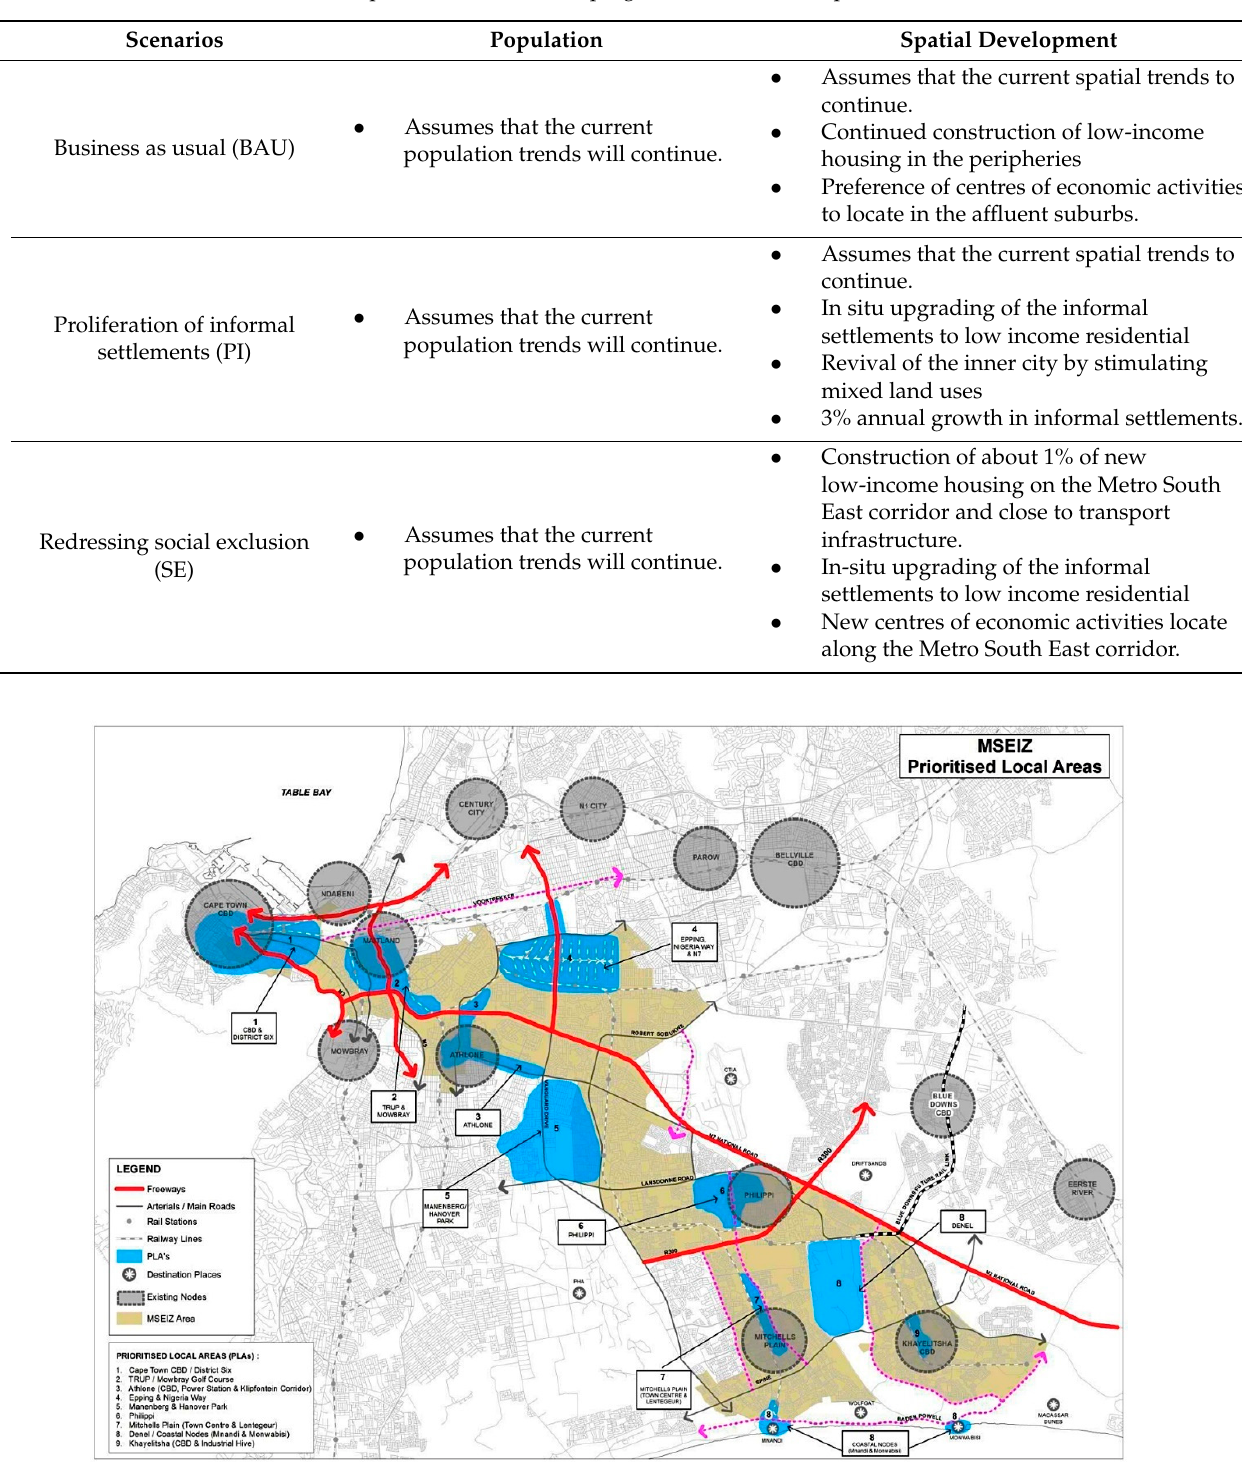
Table 6. Assumptions made in developing the land use development scenarios.